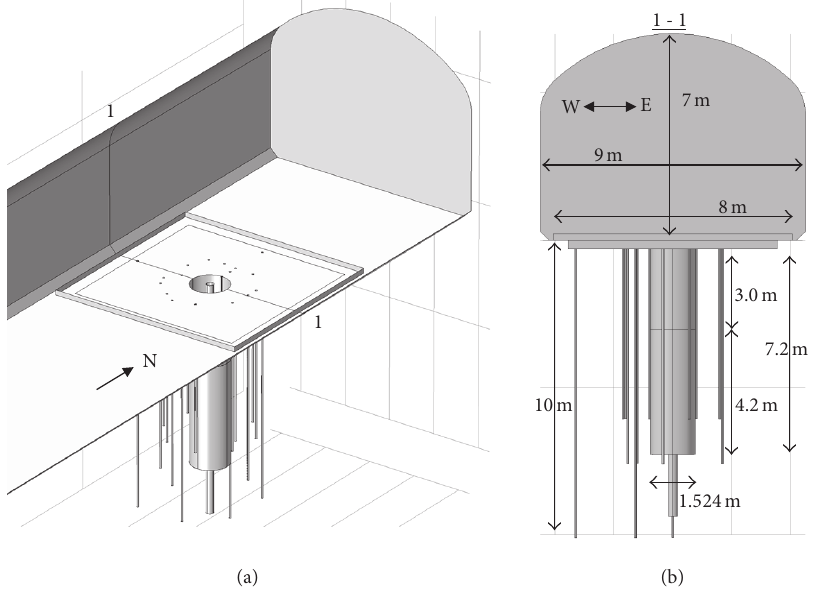
Figure 2: The end of the POSE niche (a) and the main dimensions of the experiment